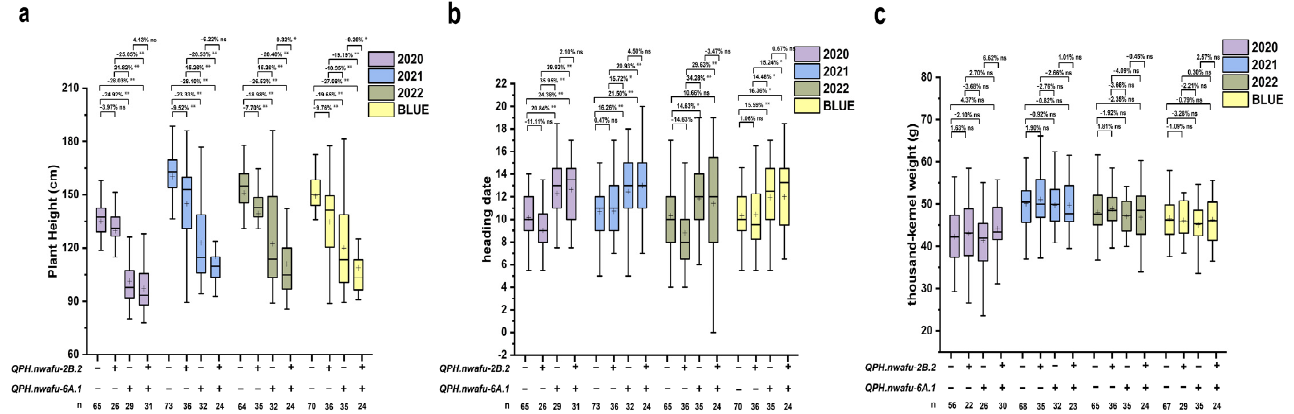
Figure 5. Interaction of QPH.nwafu-2B.2 and QPH.nwafu-6A.1 on plant height (PH) ( a ), heading date (HD) ( b ) and thousand-kernel weight (TKW) ( c ). + and − represent lines with the alleles from the Icaro and Y4 of the target locus, respectively; * and ** Significance at p < 0.05 and p < 0.01, respectively; ns: Not significant at p > 0.05.